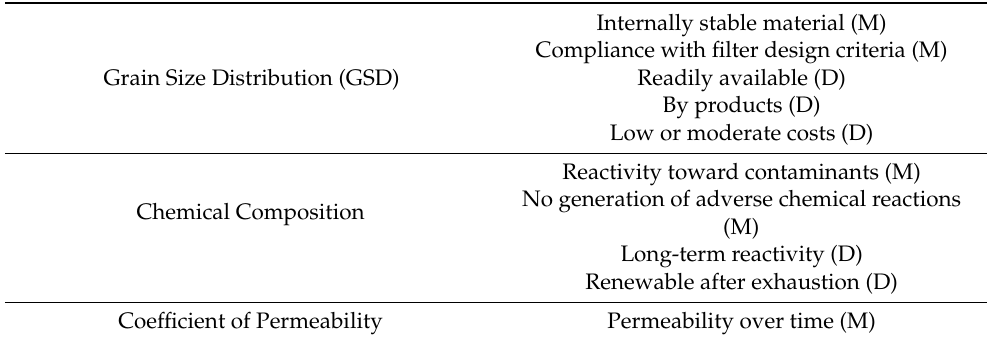
Table 1. The required properties of reactive materials in